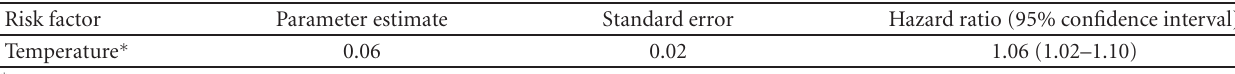
Table 6: Multivariable Cox proportional hazardsmodel ofweather related factors associated with the survival of M. bovis in the environment.